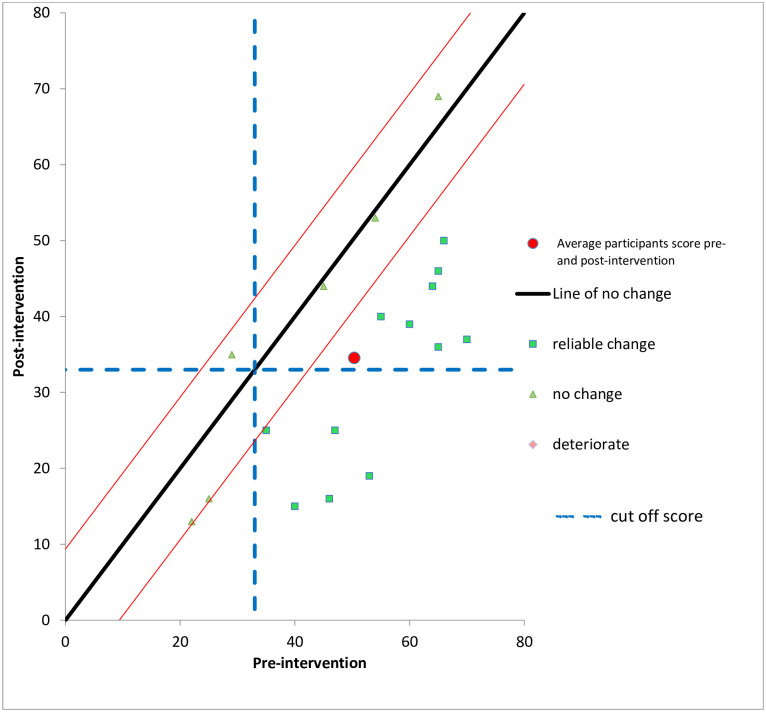
Reliable and clinically significant change in PTSD symptoms (using external criterion for PCL-5) at two weeks’ follow-up, Experiment two.(N = 18).